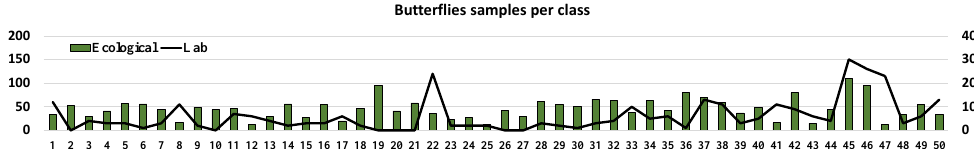
Figure 4. The number of images per class in the butterflies dataset. Ecological images are those that are taken in the natural habitat of butterflies. Such images contain background clutter and the butterfly being imaged with non-uniform orientations and illumination conditions. The lab images are those of the butterfly specimen preserved in the lab. Hence, these images do not contain the background clutter, and the images are taken with minimal differences in orientation and illumination. The left y-axis (min = 0, max = 300) represents the count of ecological images where the right y-axis (min = 0, max = 40) represents the count of lab